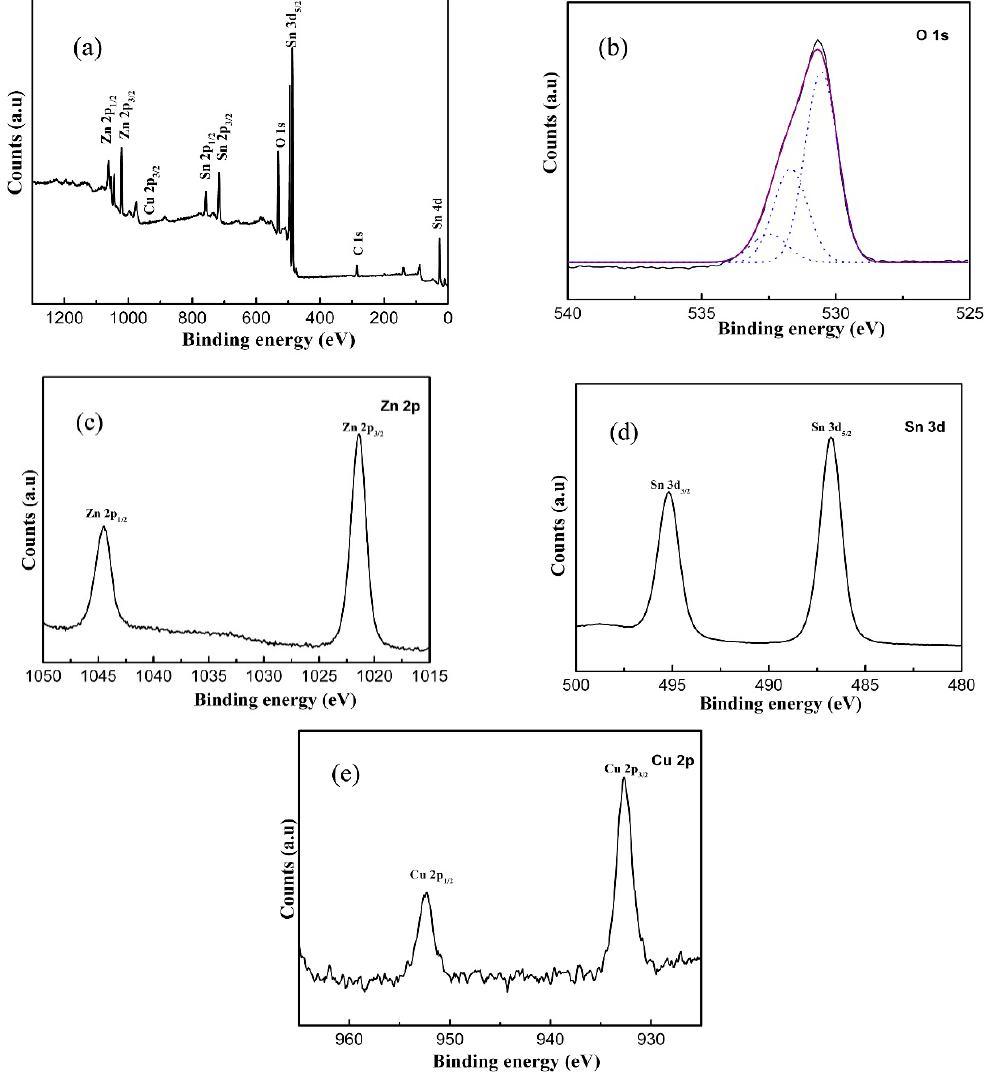
Figure 4. XPS spectra of the ZSC1.5 sample: ( a ) survey spectrum, ( b ) O 1s, ( c ) Zn 2p, ( d ) Sn 3d, ( e ) Cu 2p.